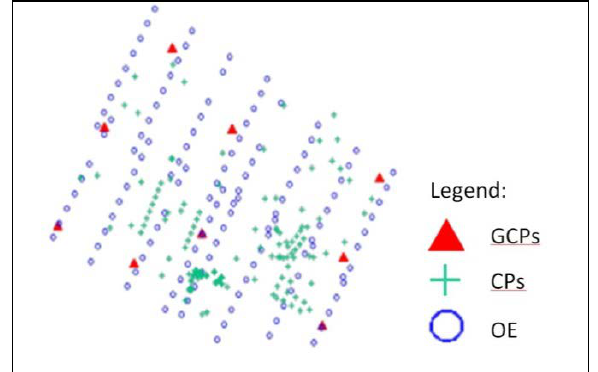
Figure 4 – Distribution of 9 GCPs for the block orientation in the a) version.